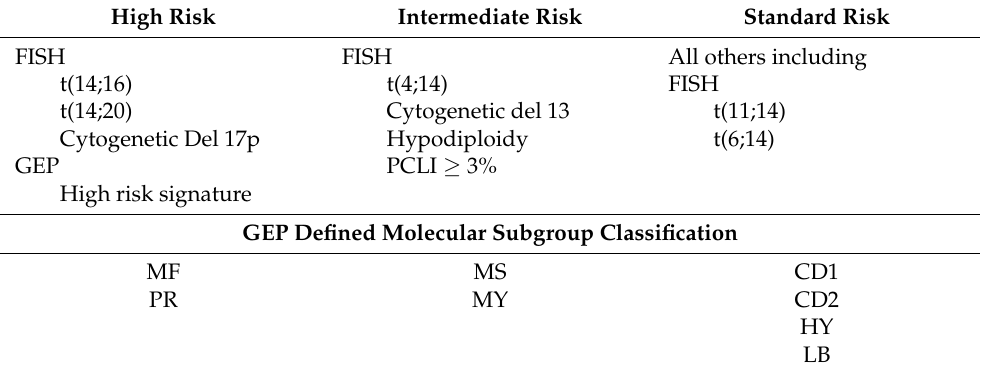
Figure 3. Myeloma Subgroups Exhibit Unique Cytogenetic Signatures Cytogenetic profiles from 97 patient samples were categorized into one of eight defined subgroups based on gene expression profiles. Results represent the average cytogenetic profiles for each of the 8 subgroups. Table 1. MM mSMART Risk